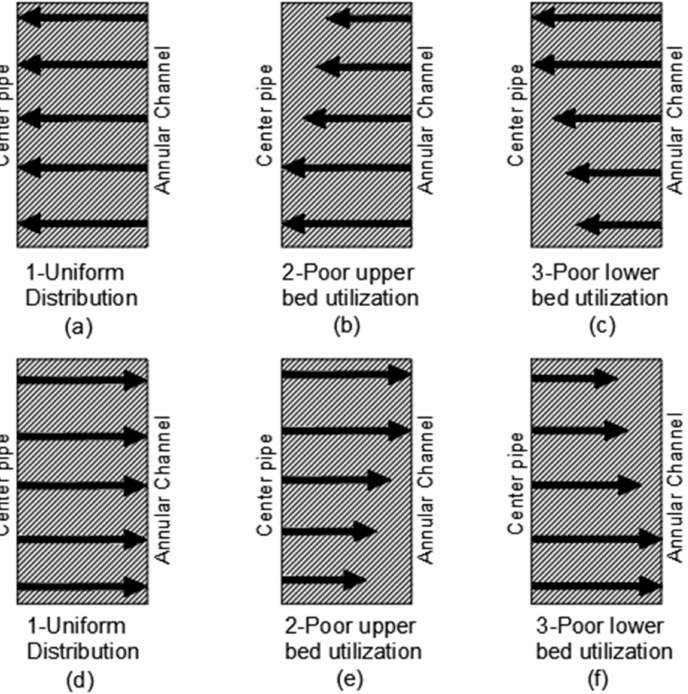
Figure 2. Flow distributions in a radial flow reactor for CP configurations ( a – c ) and CF configurations ( d – f ). The arrow length represents the mass magnitude